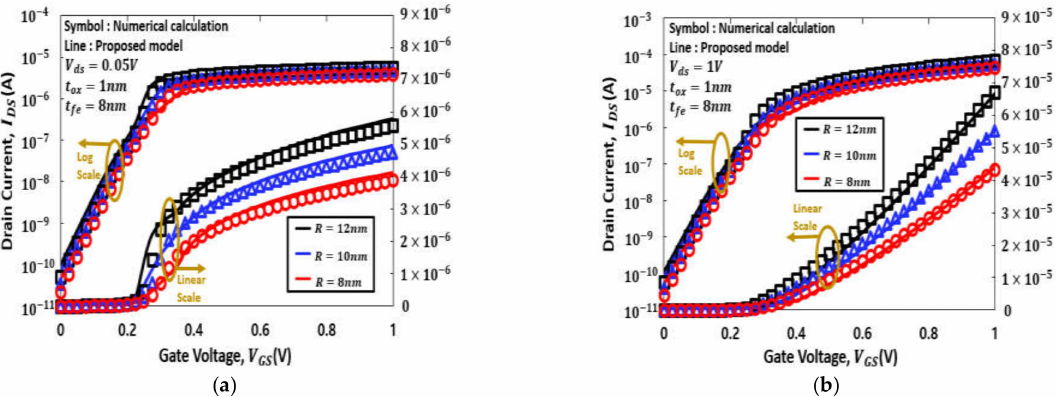
Figure 6. Result of drain current versus gate-to-source voltage when radius varies with R = 8, 10, and 12 nm; ( a ) low drain bias; ( b ) high drain bias.